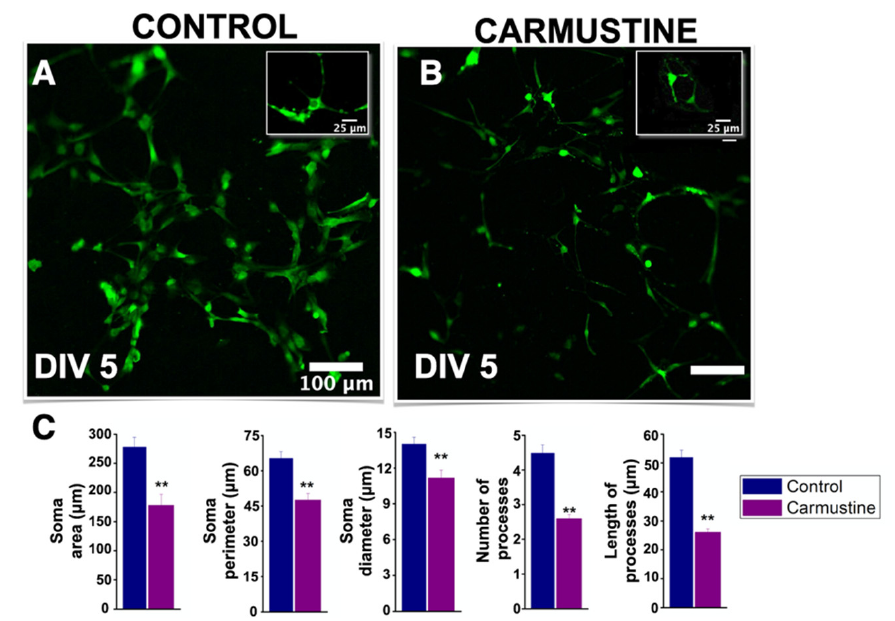
Figure 5. Decreased morphological complexity of carmustine treated astrocytes in vitro. ( A , B ). Astrocytes from control and carmustine-treated mice. The morphological complexity and extent of astrocyte processes are evident in this representative image at DIV5. ( B ). Astrocytes from carmustine treated mice showed a reduced number of processes that were retracted. ( C ). Comparative analysis between the control group and the carmustine-treated group for each parameter: soma area, soma perimeter, soma diameter, number of processes and length of the processes. (3 to 5 astrocyte cells were analyzed from each experiment; Control n = 4, Carmustine n = 4). Data are represented as the mean ± standard error of the mean. ** indicates significant difference ( p < 0.001).